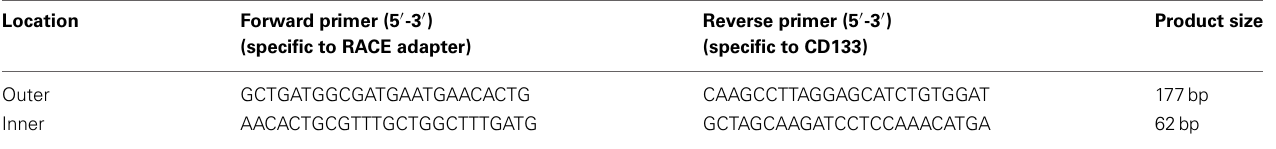
Table 2 | Primers used for validating CD133 novel TSS.